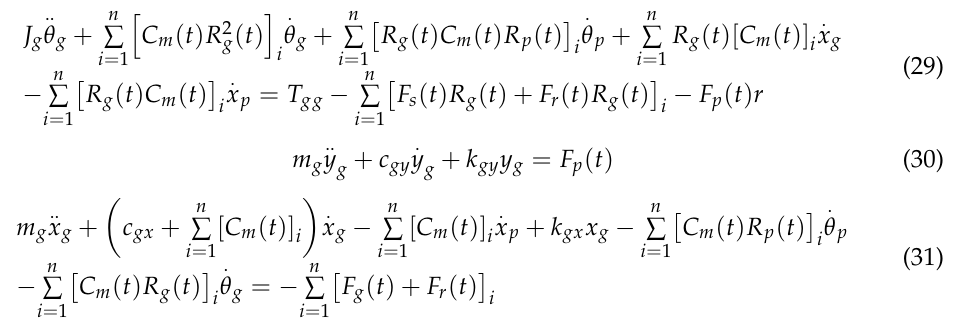
Table 2. Under the experimental conditions of input rated torque 500 Nm and preset speed 1000 r/min, the unknown dynamic characteristics of GTS are